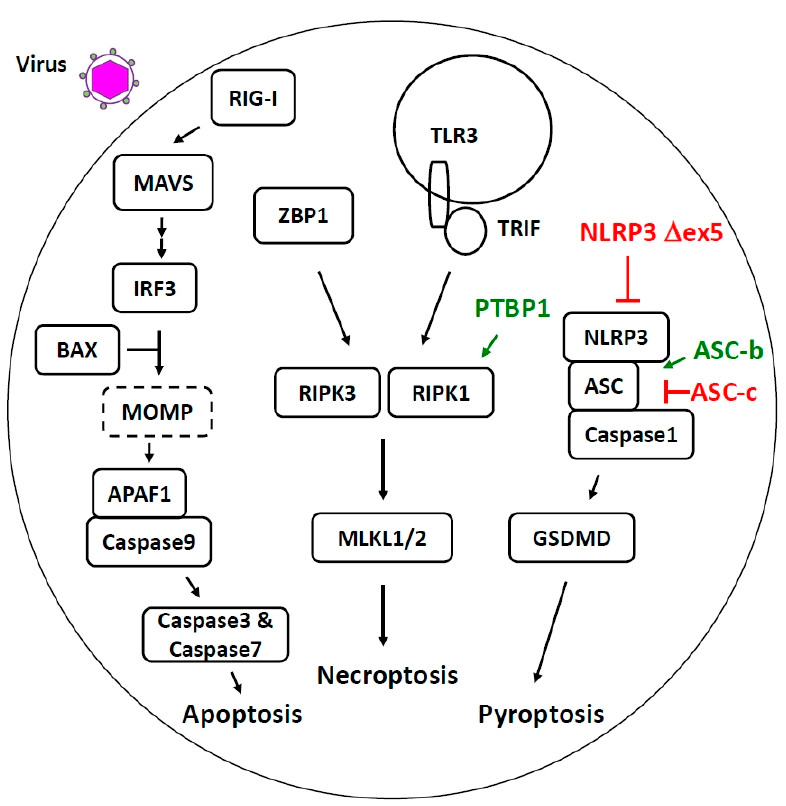
Figure 2. Alternative splicing regulates host cell death pathways activated during viral infection.